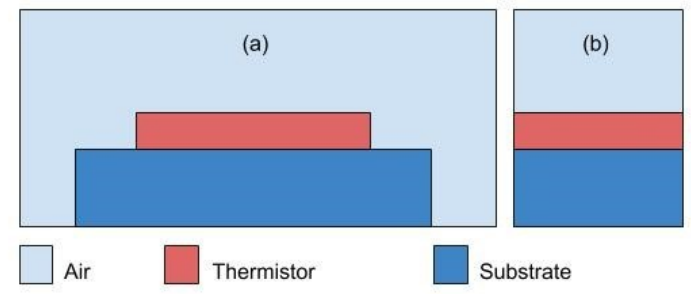
Figure 1. General sensor design; ( a ) x-y plane; ( b ) z-y plane.